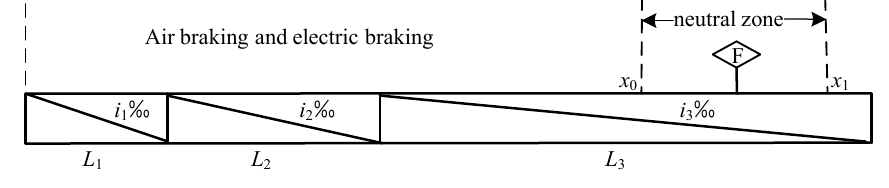
Figure 1. Long and steep